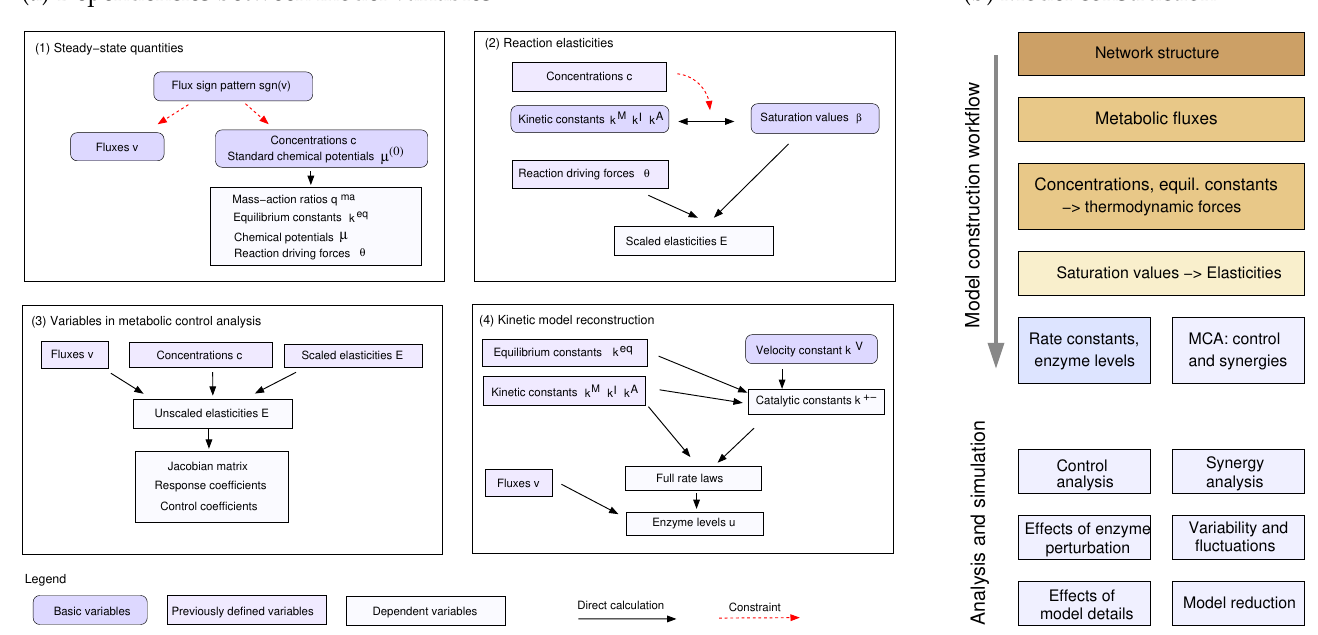
Figure 2. Dependence schema and systematic model construction. ( a ) Dependencies between model variables (kinetic constants and state variables) in kinetic metabolic models. A dependence schema describes physical or logical dependencies between variables and can serve as a blueprint for model construction. For simplicity, the schema is shown in four parts, corresponding to four steps of model construction. (1) Metabolic state phase. Fluxes and thermodynamic forces must have the same signs. Predefined flux directions define sign constraints on fluxes and thermodynamic forces, and fluxes and chemical potentials can be sampled under these constraints. (2) Kinetics phase. Saturation values β M